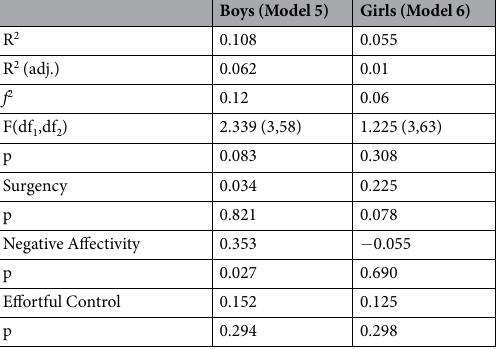
Table 3. CATREG models in boys (Model 5) and girls (Model 6) regressing the total COBEL scores on the three temperamental factors. Df 1 and df 2 denote regression and residual degrees of freedom, respectively. The predictor-related values represent β s